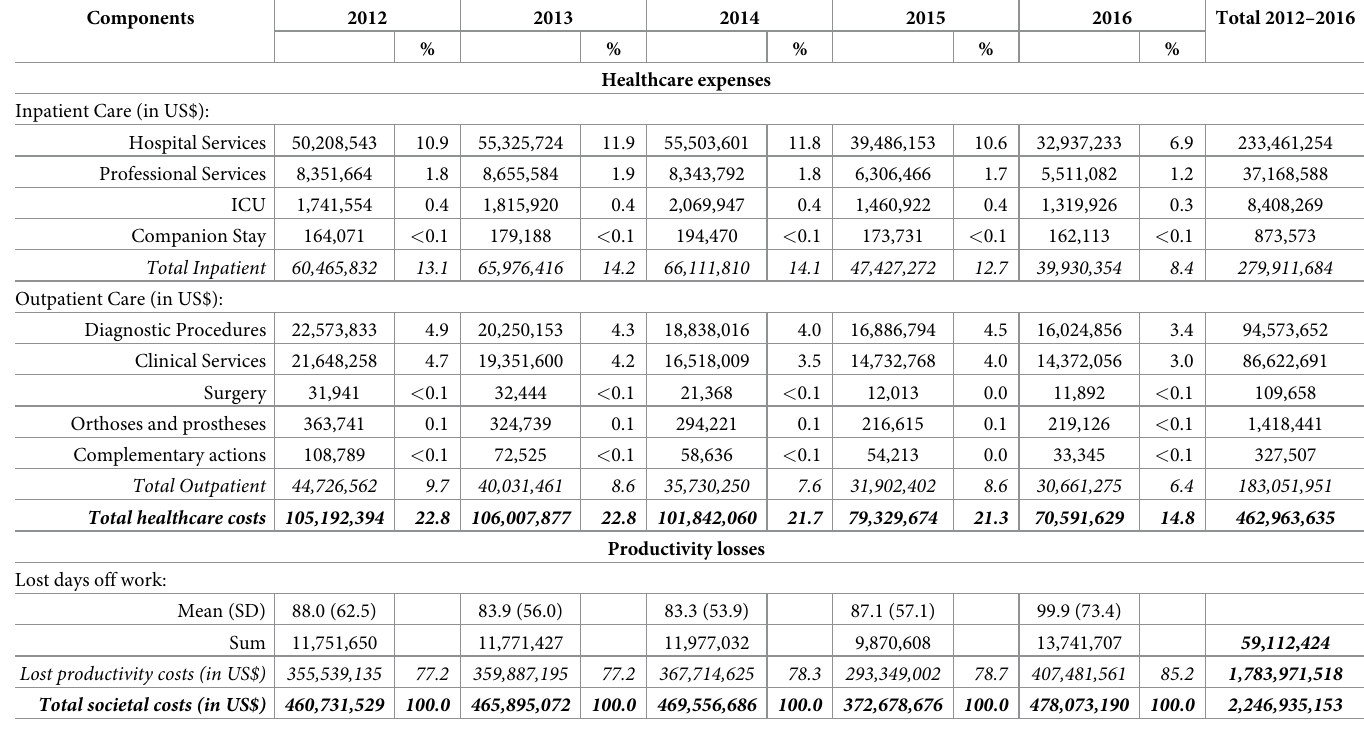
Table 1. Overview of the healthcare expenditures and productivity losses attributable to Low Back Pain (LBP) in Brazil, from 2012 to 2016, percentages of costs were referenced (%) to the total amount (direct plus indirect costs), for each year.